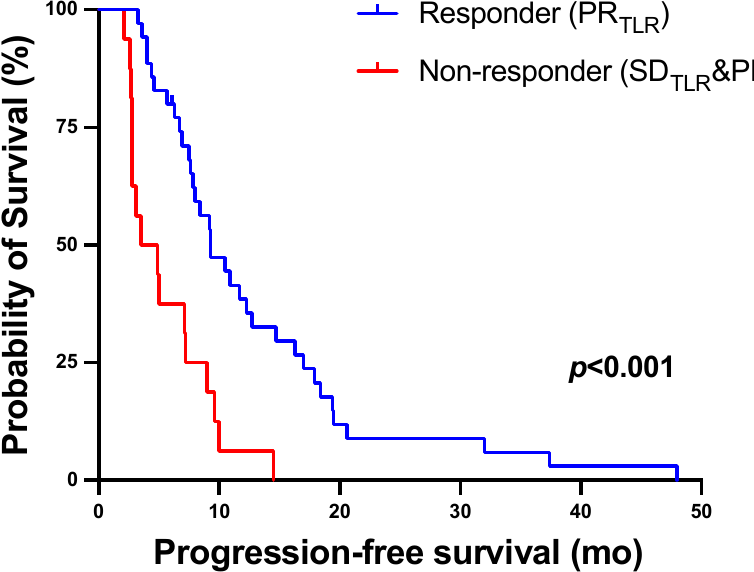
Figure 6. Kaplan–Meier curves for PFS stratified by molecular-imaging response assessment using TLR after two cycles of 177 Lu-PSMA-617 RLT.